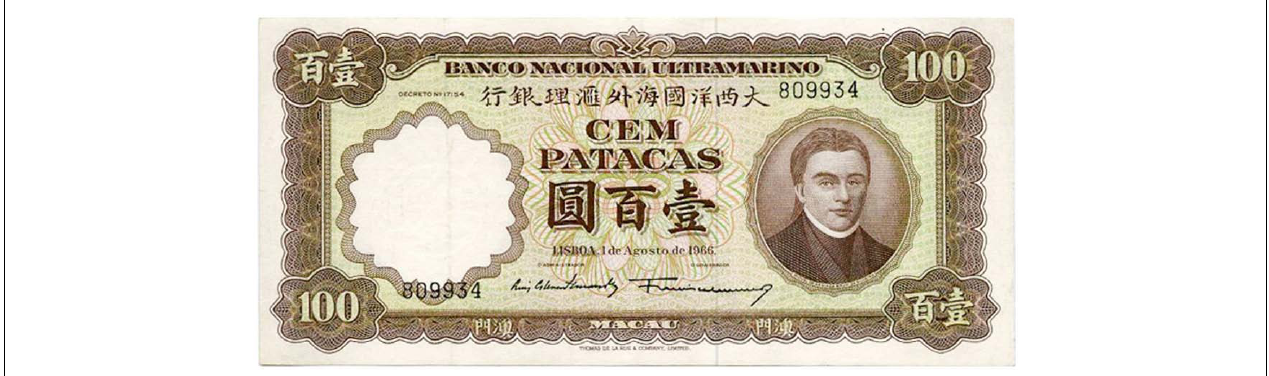
FIGURE 3 |The 1952 version of the 100 Macanese pataca banknote. Both the Chinese name of the issuing bank and the denomination